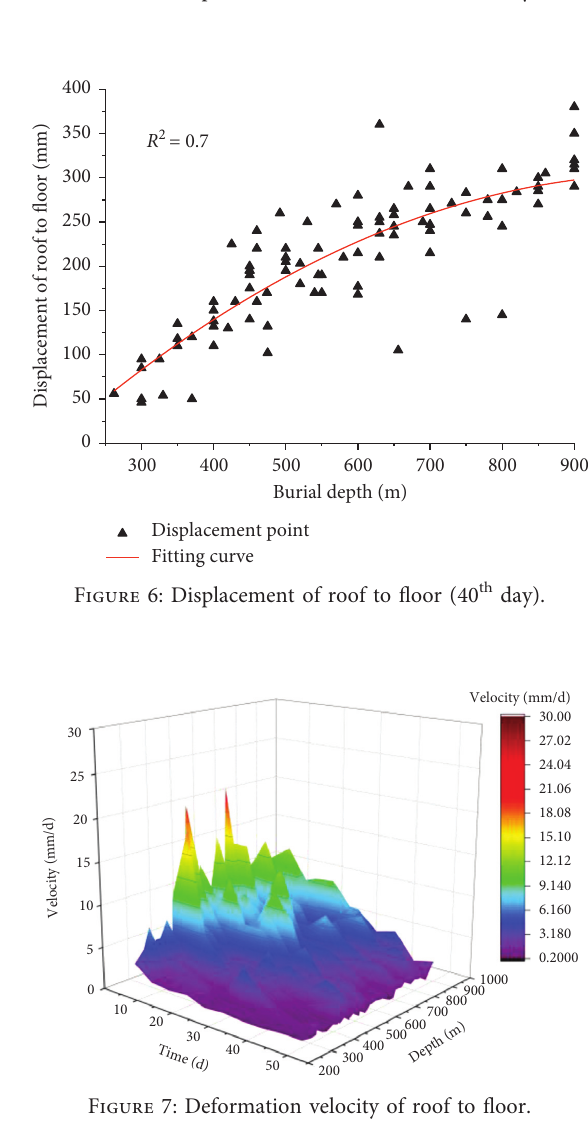
Figure 5: Displacement of roof to floor (45 th day).